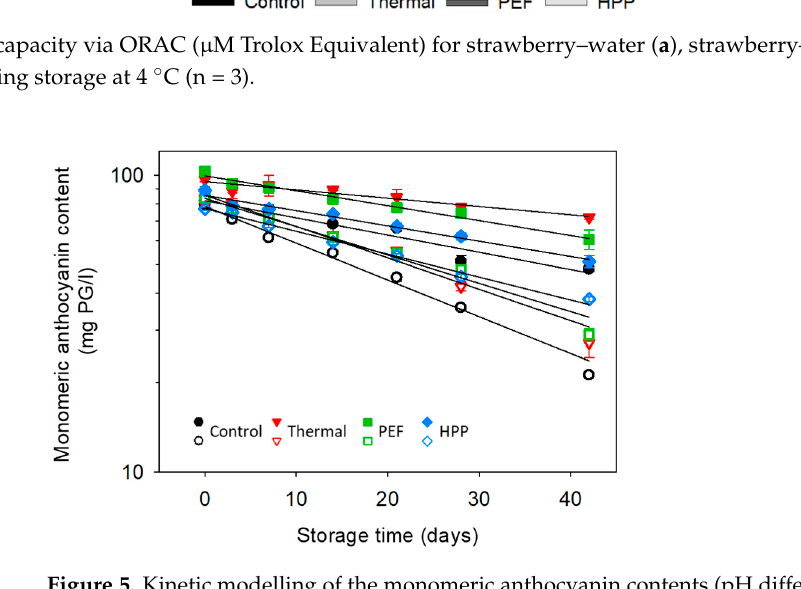
Figure 6. Kinetic modelling for the relative anthocyanin contents in the aqueous phase measured via HPLC-DAD during refrigerated storage at 4 °C for the strawberry-kale mix (empty) and straw- berry-water (filled) (n = 3).